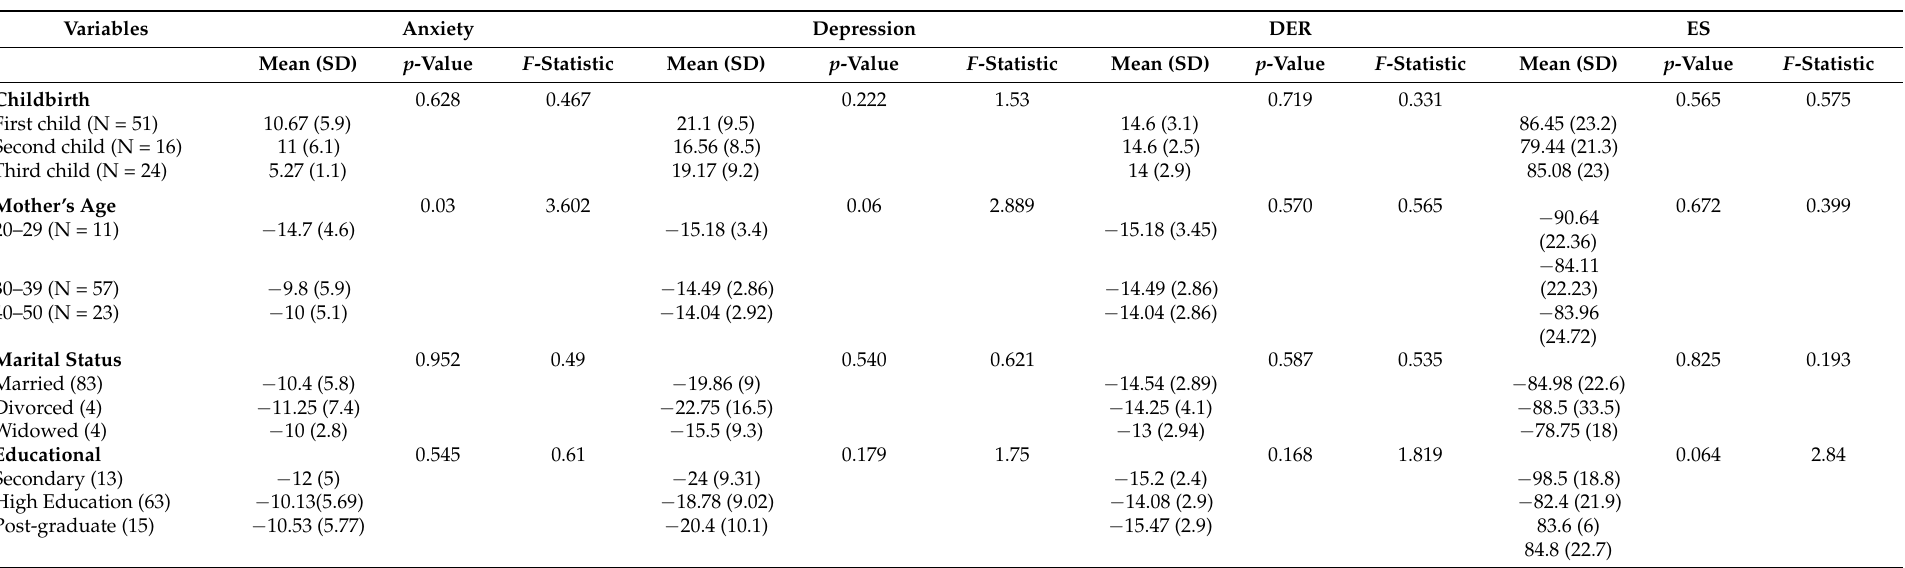
Table 3. Demographic data and the level of anxiety, depression, DER, and ES for mothers of autistic children (N =